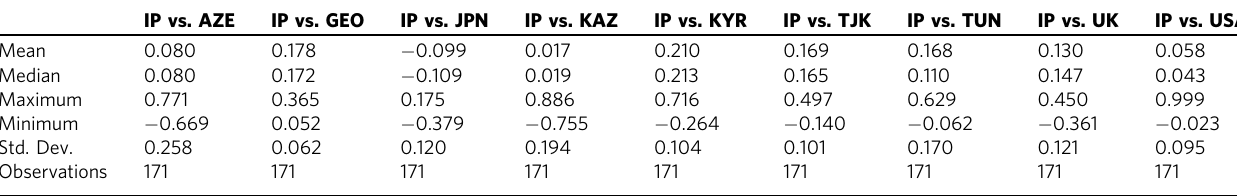
Table 8 Descriptive statistics of estimated DCCs of nine beef-importing countries.